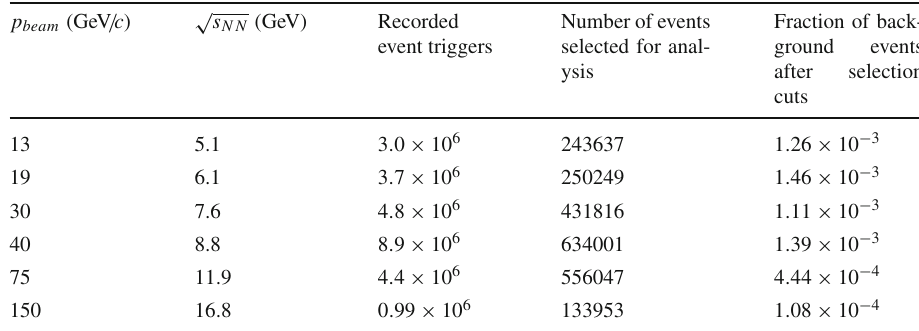
Table 1 Basic beam properties and number of events recorded and used in the analysis of 40 Ar+ 45 Sc interactions at incident momenta of 13 A , 19 A , 30 A , 40 A , 75 A and 150 A GeV /